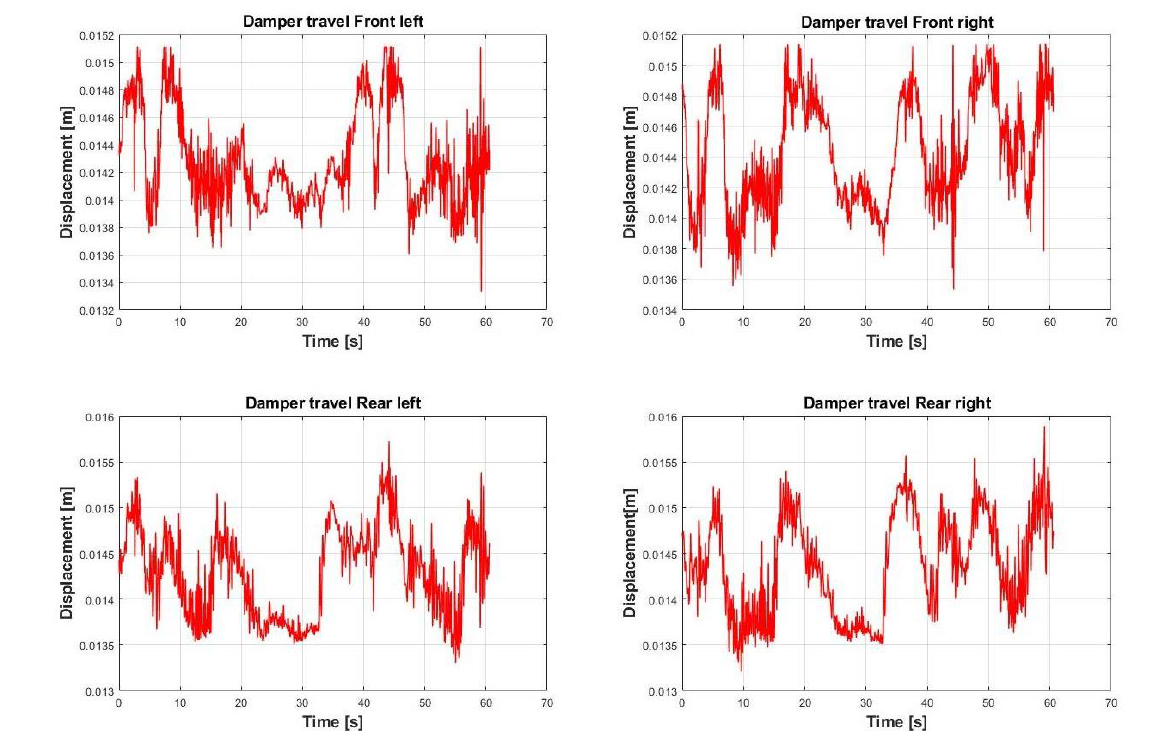
Figure 12. Damper travels vs.